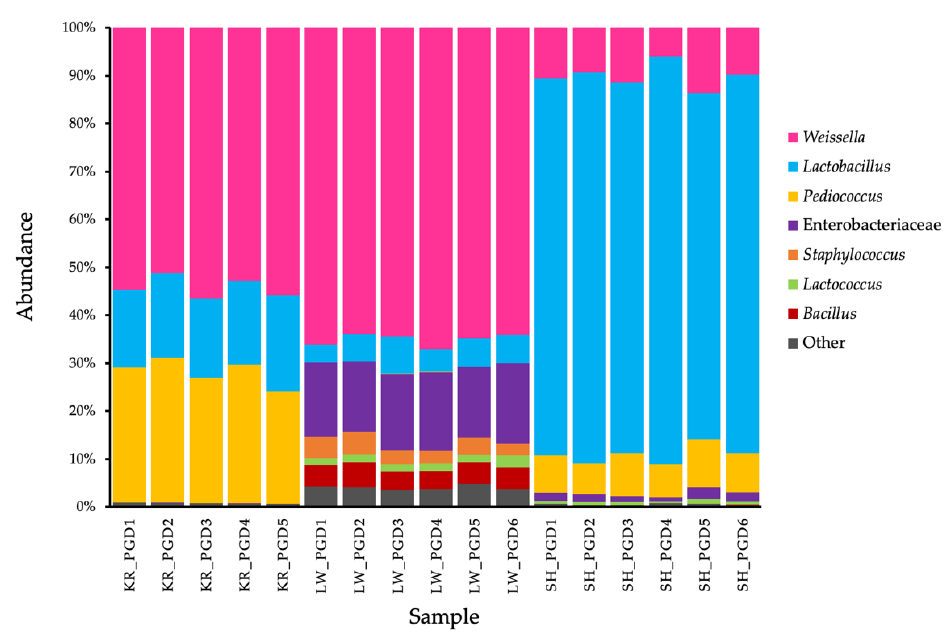
Figure 2. The proportion of bacterial taxa found in the PGDs of 3 ethnic groups including Karen (KR_PGD), Lawa (LW_PGD), and Shan (SH_PGD).